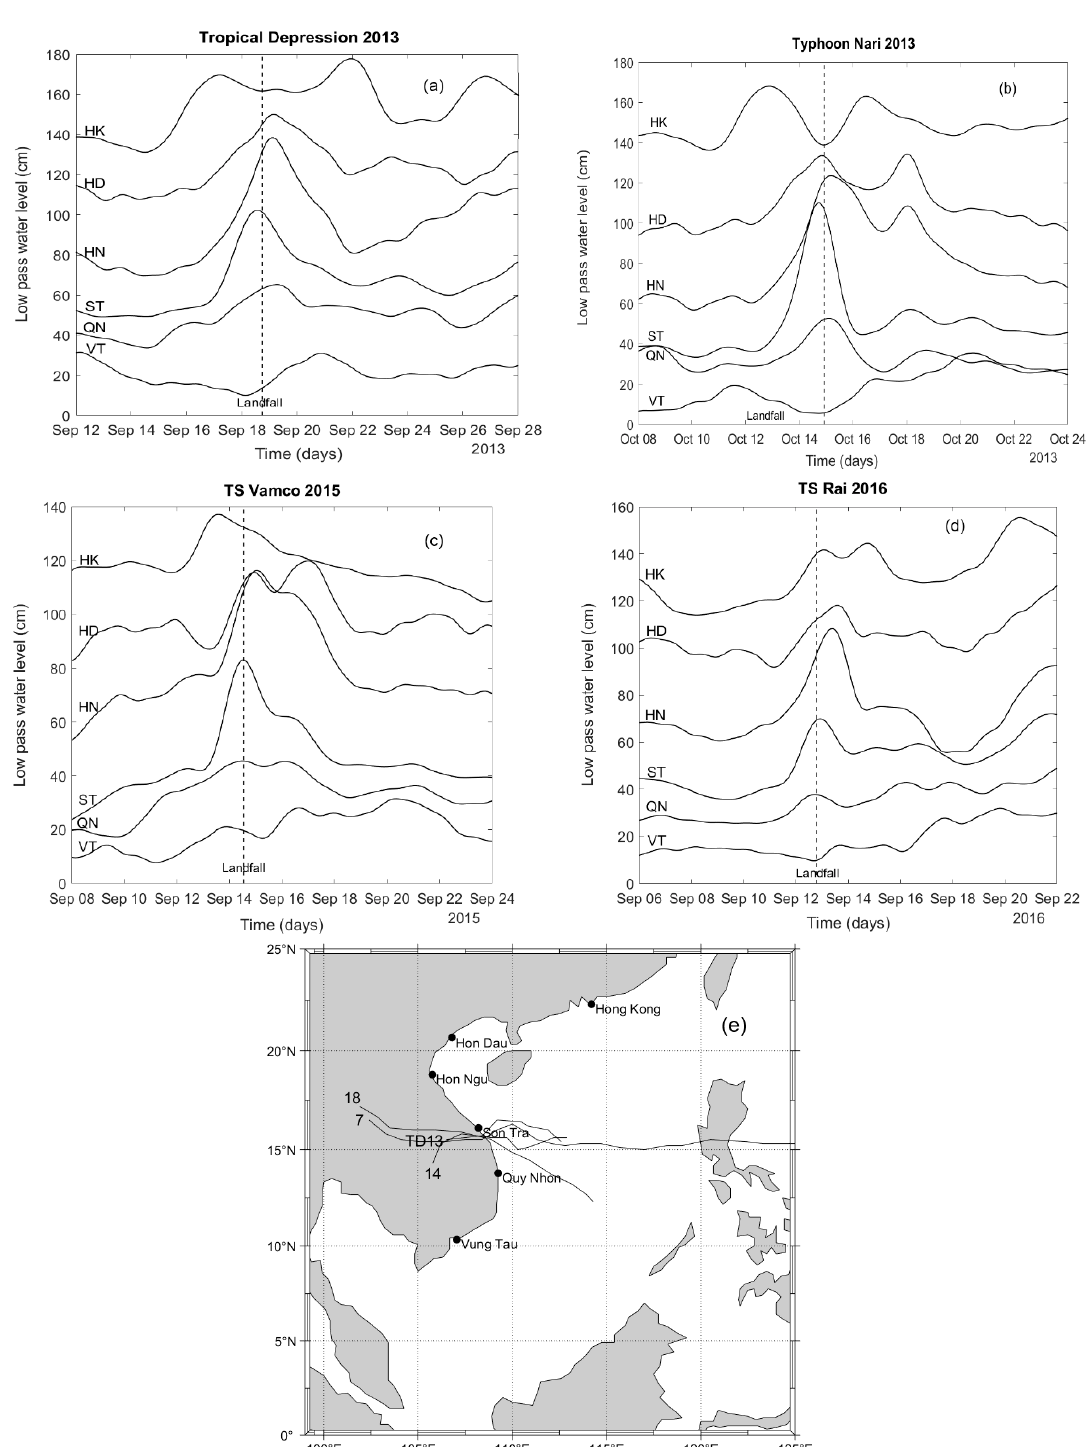
Figure 16. Low-pass water level at all station during Tropical Depression (September 2013) ( a ), Typhoon Nari (October 2013) ( b ), Tropical Storm Vamco (September 2013) ( c ), Tropical Storm Rai (September 2016) ( d ), and their paths ( e ). Numbers refer to typhoons listed on Figure 3.